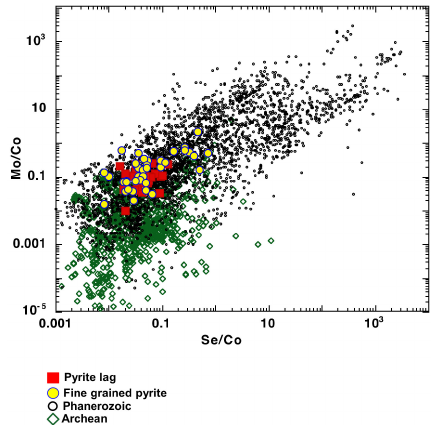
Figure 12. Comparison of Se / Co vs Mo / Co in the Bijaigarh Black Shale unit with Archean and Phanerozoic sedimentary pyrites [16,18].